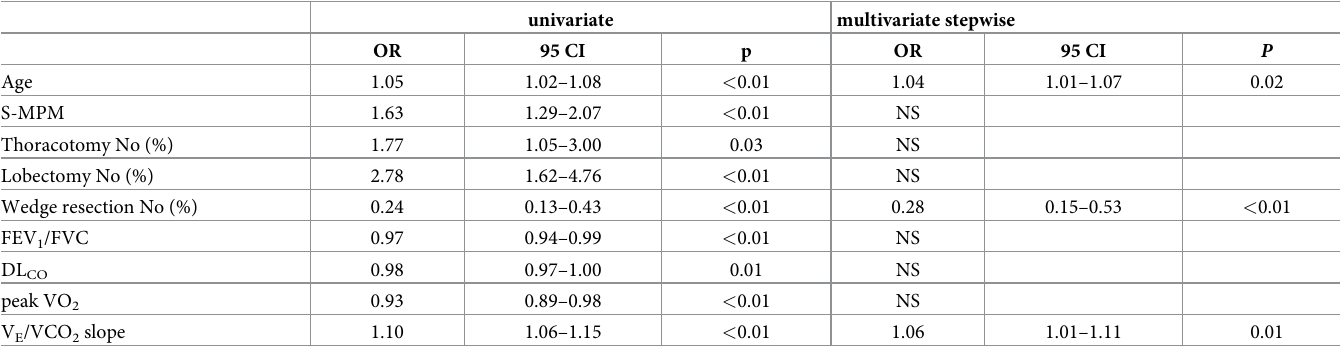
Table 5. Logistic regression